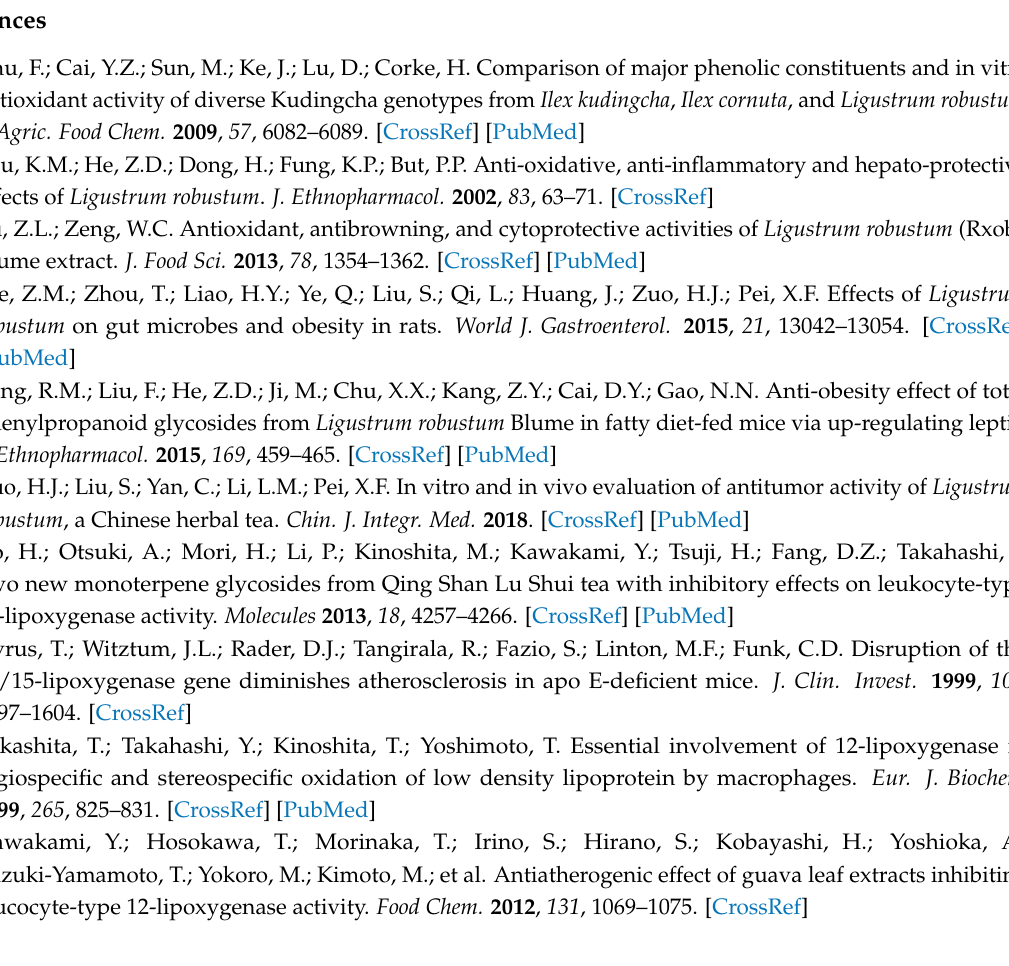
Supplementary Materials: The following are available online, Figure S1: 1 H-NMR spectrum of liguroside C in acetone- d 6 -D 2 O (9:1, v / v ) (600 MHz); Figure S2: 13 C-NMR spectrum of liguroside C in acetone- d 6 -D 2 O (9:1, v / v ) (151 MHz); Figure S3: 1 H- 1 H COSY NMR spectrum of liguroside C in acetone- d 6 -D 2 O (9:1, v / v ) (600 MHz); Figure S4: HSQC NMR spectrum of liguroside C in acetone- d 6 -D 2 O (9:1, v / v ) (600 MHz); Figure S5: HMBC NMR spectrum of liguroside C in acetone- d 6 -D 2 O (9:1, v / v ) (600 MHz); Figure S6: 1 H-NMR spectrum of liguroside D in acetone- d 6 -D 2 O (9:1, v / v ) (600 MHz); Figure S7: 13 C-NMR spectrum of liguroside D in acetone- d 6 -D 2 O (9:1, v / v ) (151 MHz); Figure S8: 1 H- 1 H COSY NMR spectrum of liguroside D in acetone- d 6 -D 2 O (9:1, v / v ) (600 MHz); Figure S9: HSQC NMR spectrum of liguroside D in acetone- d 6 -D 2 O (9:1, v / v ) (600 MHz); Figure S10: HMBC NMR spectrum of liguroside D in acetone- d 6 -D 2 O (9:1, v / v ) (600 MHz); Figure S11: HPLC profiles of ligurosides A, B, C, and